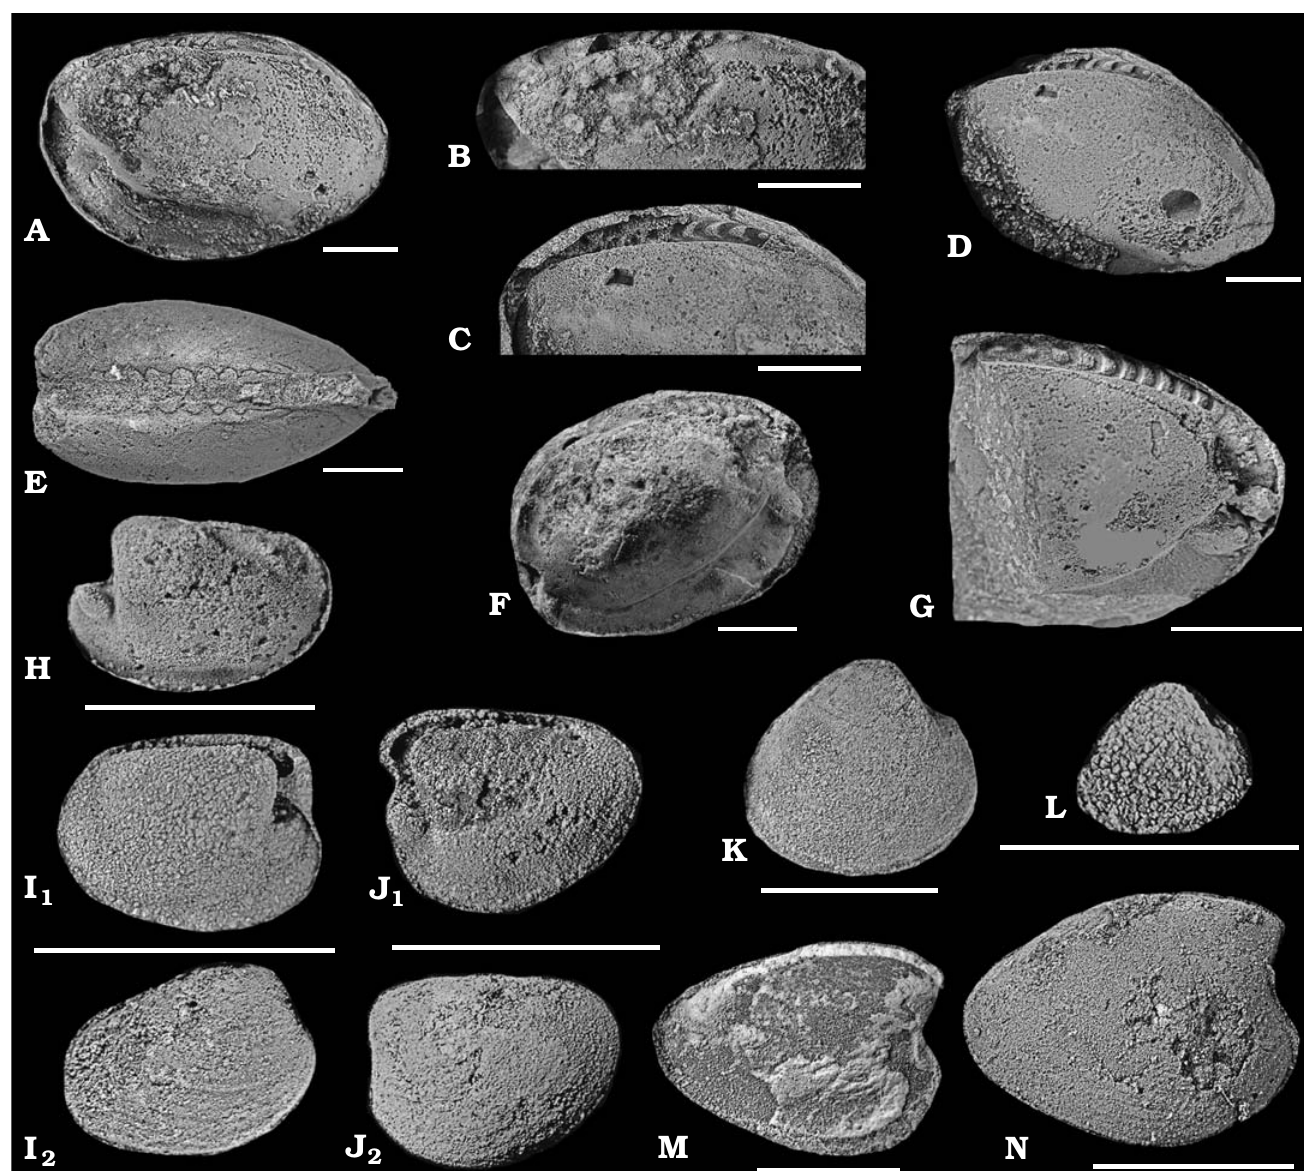
Fig. 10. Nucularcid bivalves from the Stairway Sandstone, Middle Ordovician, Australia. Internal (A–H, I 1 , J 1 , K–N) and external (I 2 , J 2 ) moulds. A–J . Stheno donta eastii Pojeta and Gilbert-Tomlinson, 1977 from the Petermann Creek. A–D . Specimens in left-lateral views with chevron-shaped palae- otaxodont teeth ( A , CPC 41455; B , CPC 41456; C , CPC 41456; D , CPC 41457). E . Specimen in dorsal view with teeth (CPC 41458). F , G . Specimens in right-lateral view with teeth and ventral border ( F , CPC 41459; G , CPC 41460). H . Specimen in left-lateral view with anterior myophoric buttress preserved (CPC 41461). I . Specimen in right-lateral view showing indistinct growth lines (CPC 41462). J . Specimen in left-lateral view (CPC 41463). K , L . Sthenodonta paenesymmetrica sp. nov. from the Areyonga Gorge (K) and Petermann Creek (L), right-valves in dorsomedial views. K . Holotype (CPC 41464). L . Juvenile specimen (CPC 41465). M , N . Sthenodonta sp. A. M . Specimen (CPC 41467) from the Petermann Creek in right-lateral view with anterior muscle scars indicated and part of original shell material preserved. N . Specimen (CPC 41466) from Areyonga Gorge in right-lateral view with curved anterodorsal margin. Scale bars 10